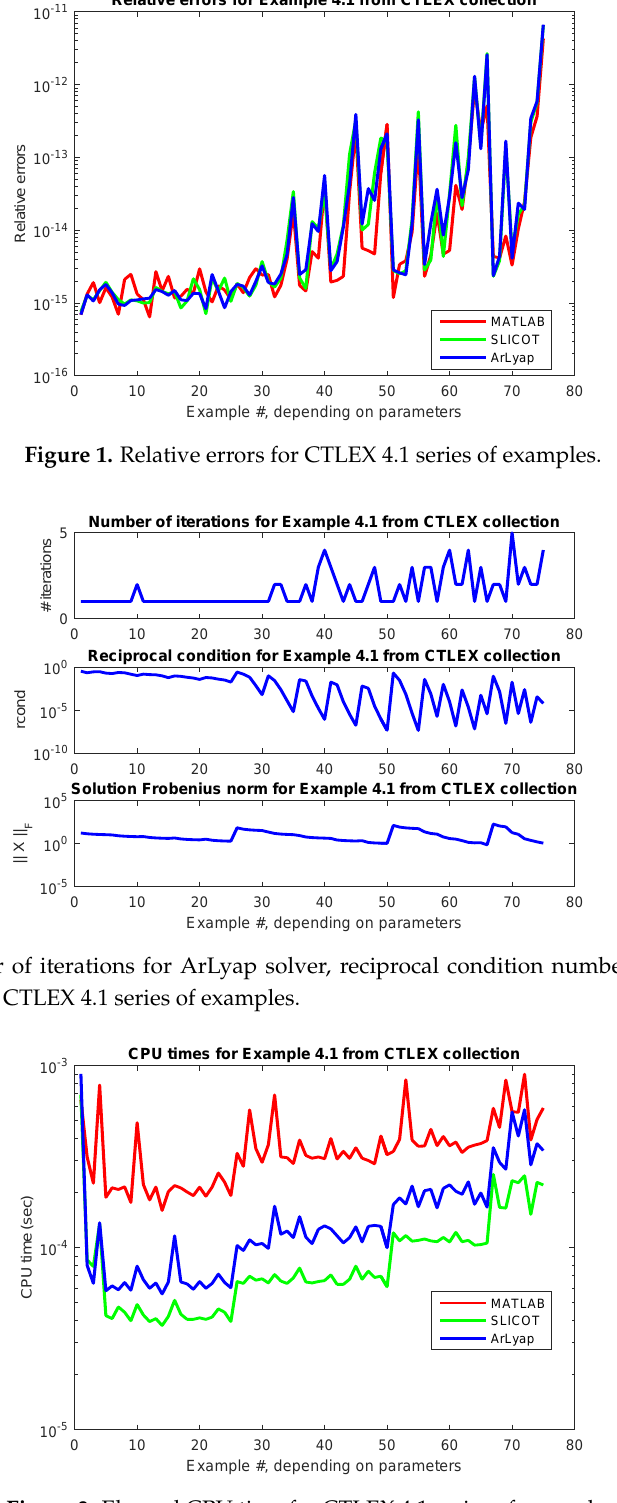
Figure 3. Elapsed CPU time for CTLEX 4.1 series of